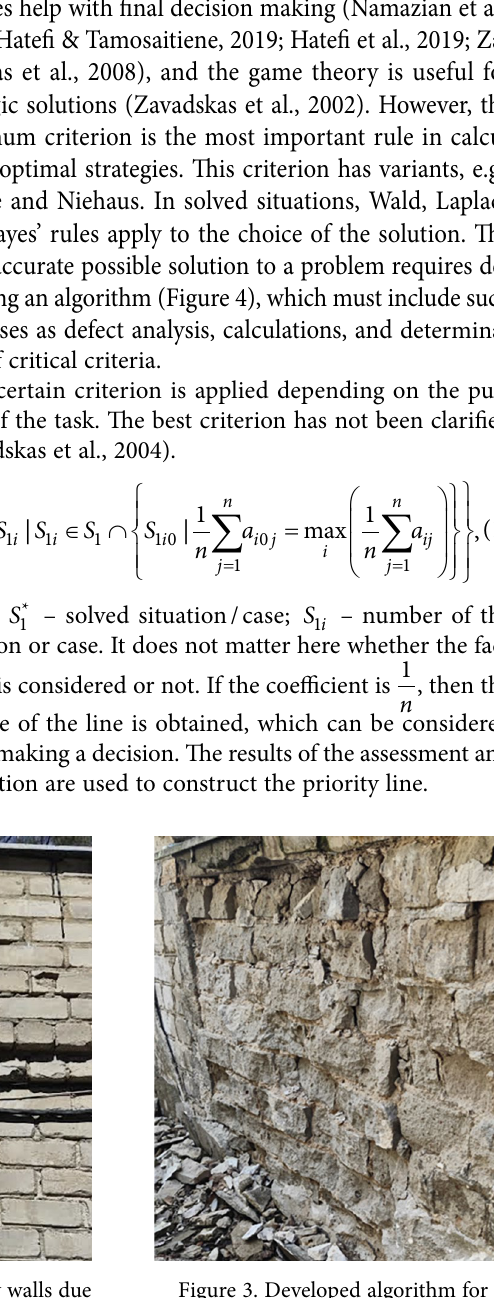
Figure 1. Defects in the movement of structures